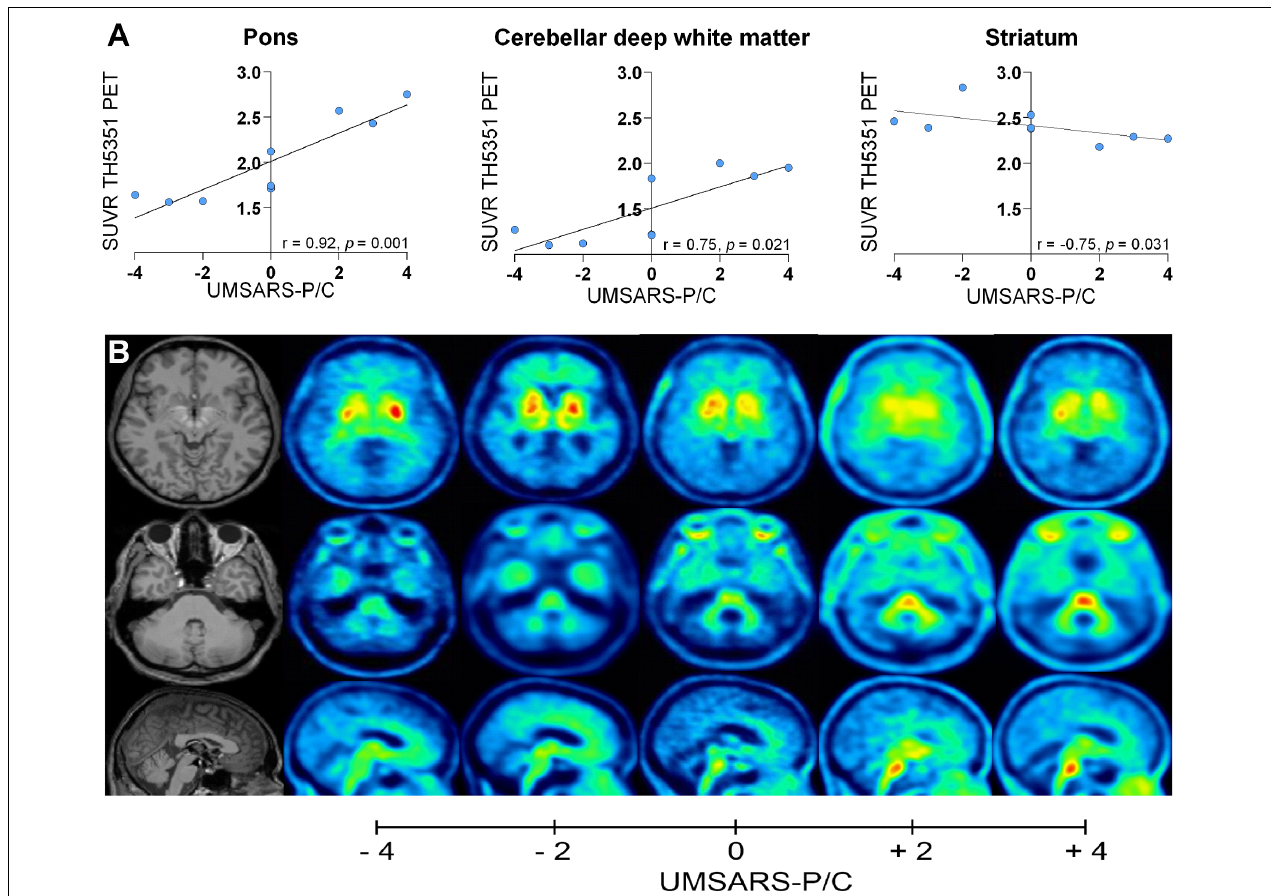
FIGURE 2 | Correlation of [ 18 F]-THK5351 tracer uptake with UMSARS-P/C: (A) Correlation of [ 18 F]-THK5351 tracer uptake in the pons, cerebellar deep white matter, and striatum with UMSARS-P/C. (B) Axial and sagittal slices showing individual tracer uptake of patients with an UMSARS-P/C score of –4, –2, 0, +2, and